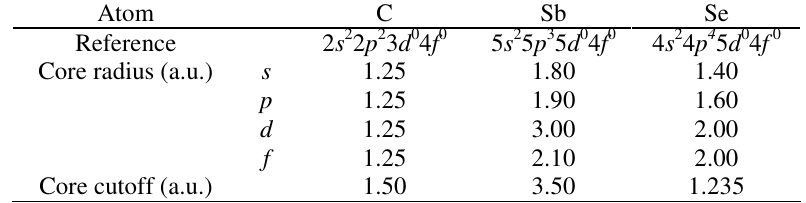
Table 1. Reference configuration and cut-off radii (a.u.) of the pseudo potentials used in this